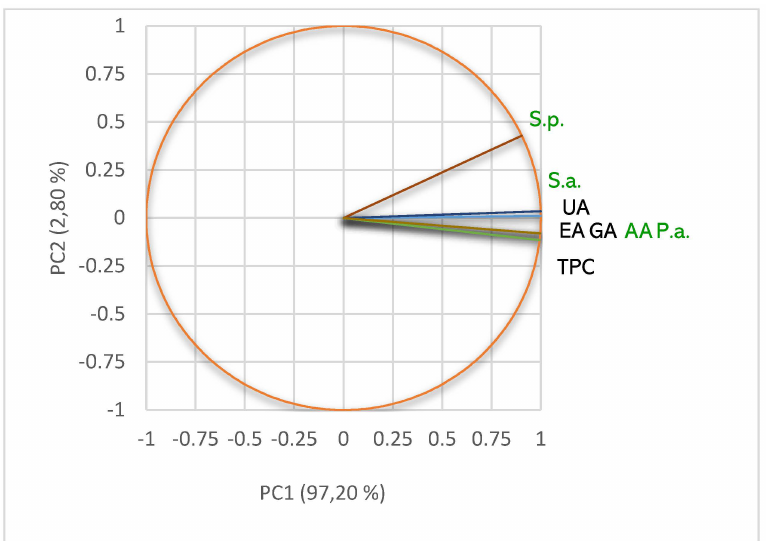
Figure 8. PCA-Correlation circle between TPC, UA, and individual polyphenols in d UBE and anti- bacterial and antiradical activities. d UBE— U. barbata dry ethanol extract, EA—ellagic acid, GA— gallic acid, UA—usnic acid, TPC—total phenolic content, AA—antiradical activity, P.a.—inhibitory activity against P. aeruginosa , S.a.—inhibitory activity against S. aureus , S.p.—inhibitory activity against S. pneumoniae.